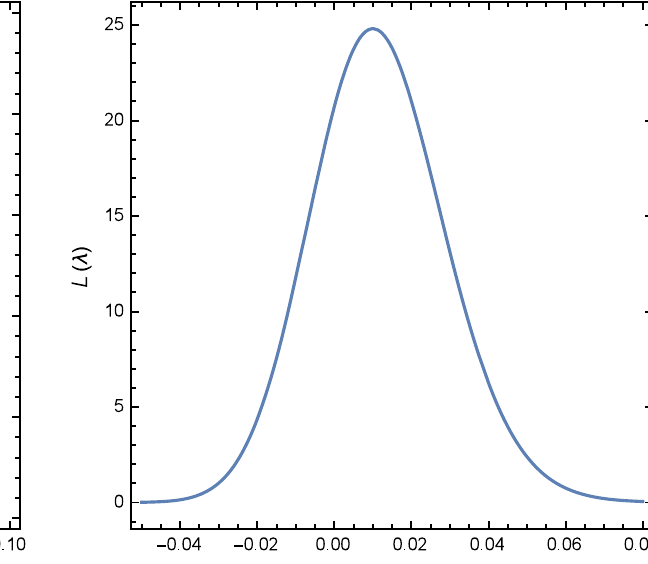
represents the best-fit value of the pair (λ,(cid:2) m 0 ) . The figure on the right is the likelihood function of λ , which is marginalized with a flat prior that becomes zero if (cid:2) m 0 is bigger than 0.38 or smaller than 0.16, suggesting − 0 . 017 < λ < 0 . 047 (2 σ confidence